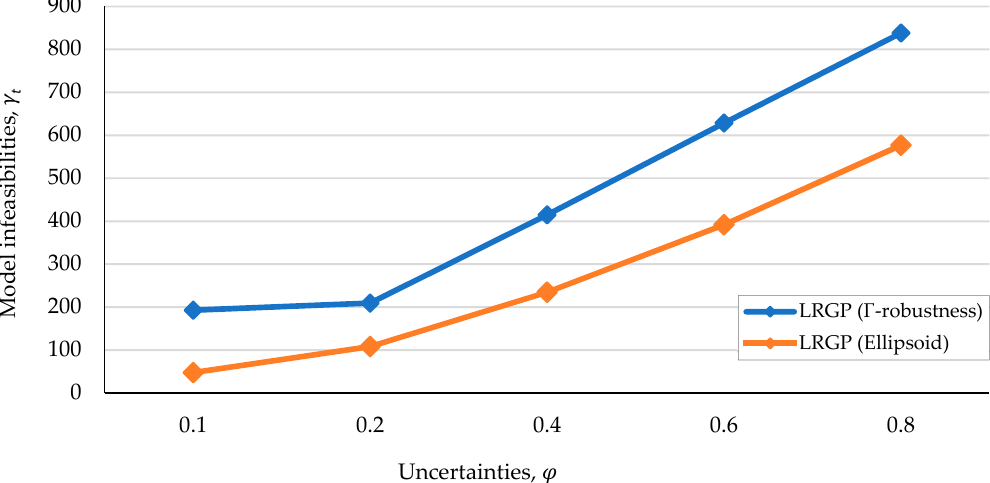
Figure 3. Constraint violated uncertainties and infeasibilities.